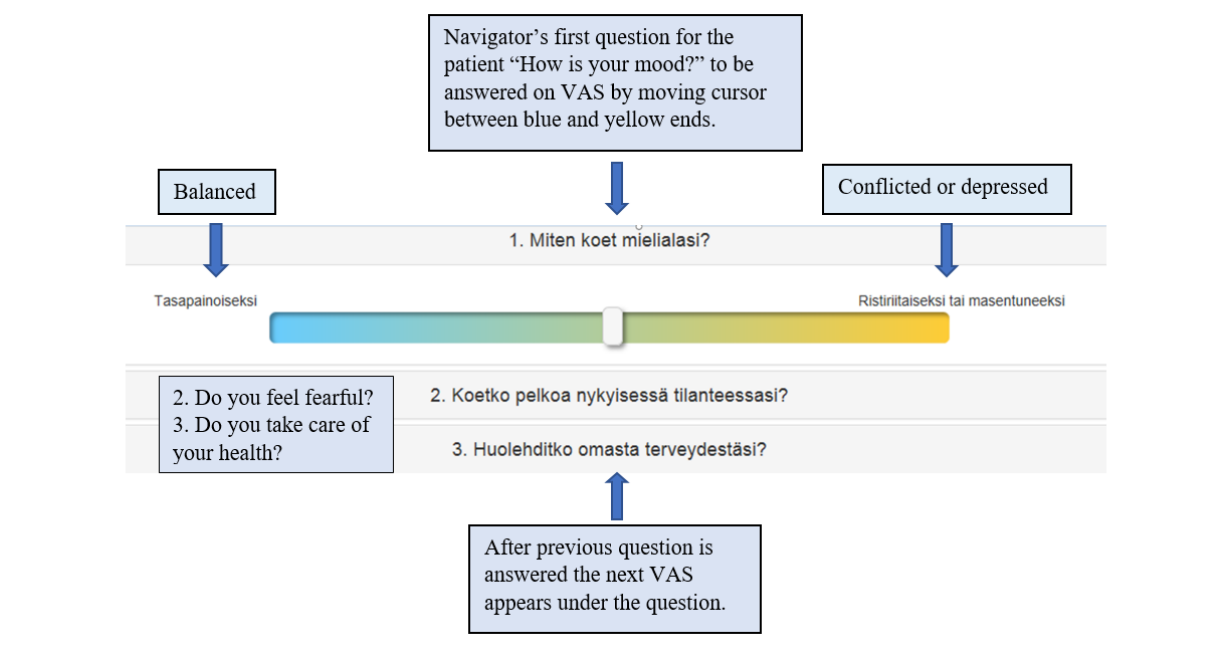
Figure 3. Navigator's first three questions for patients, showing